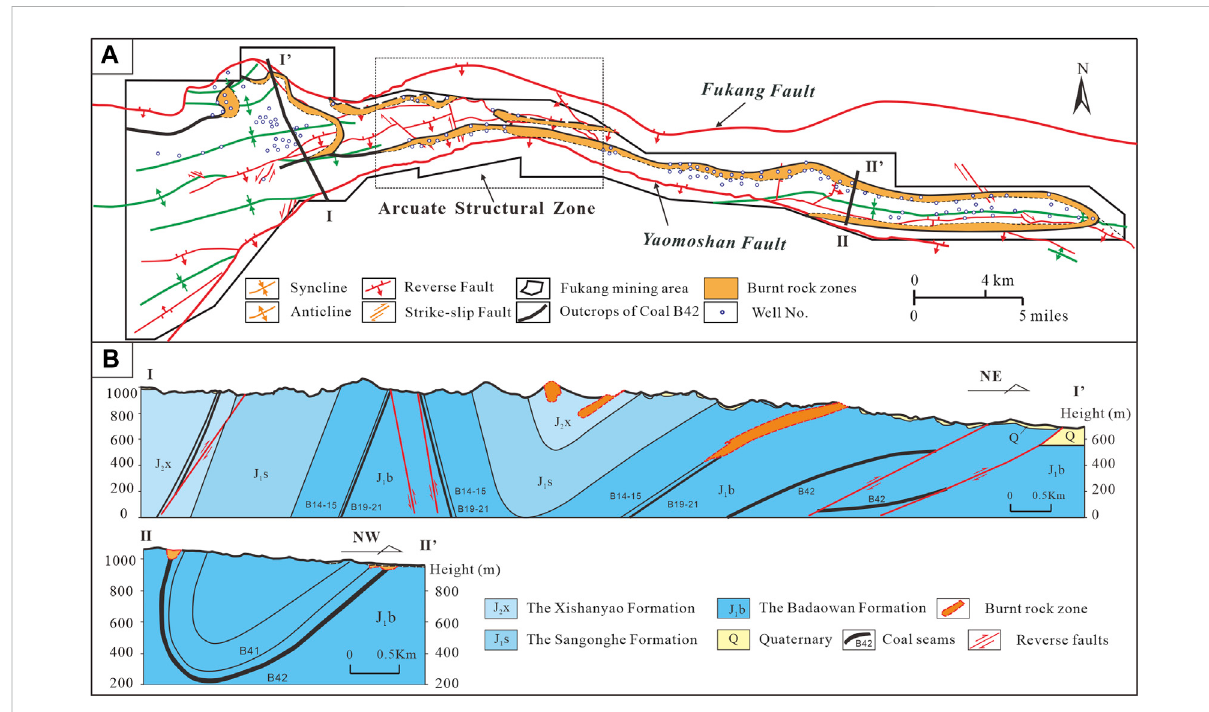
FIGURE 2 Structure outline map (A) and two cross-sections (B) of the Fukang area showing the occurrences of major faults, folds and coal seams, and distribution of burnt rock